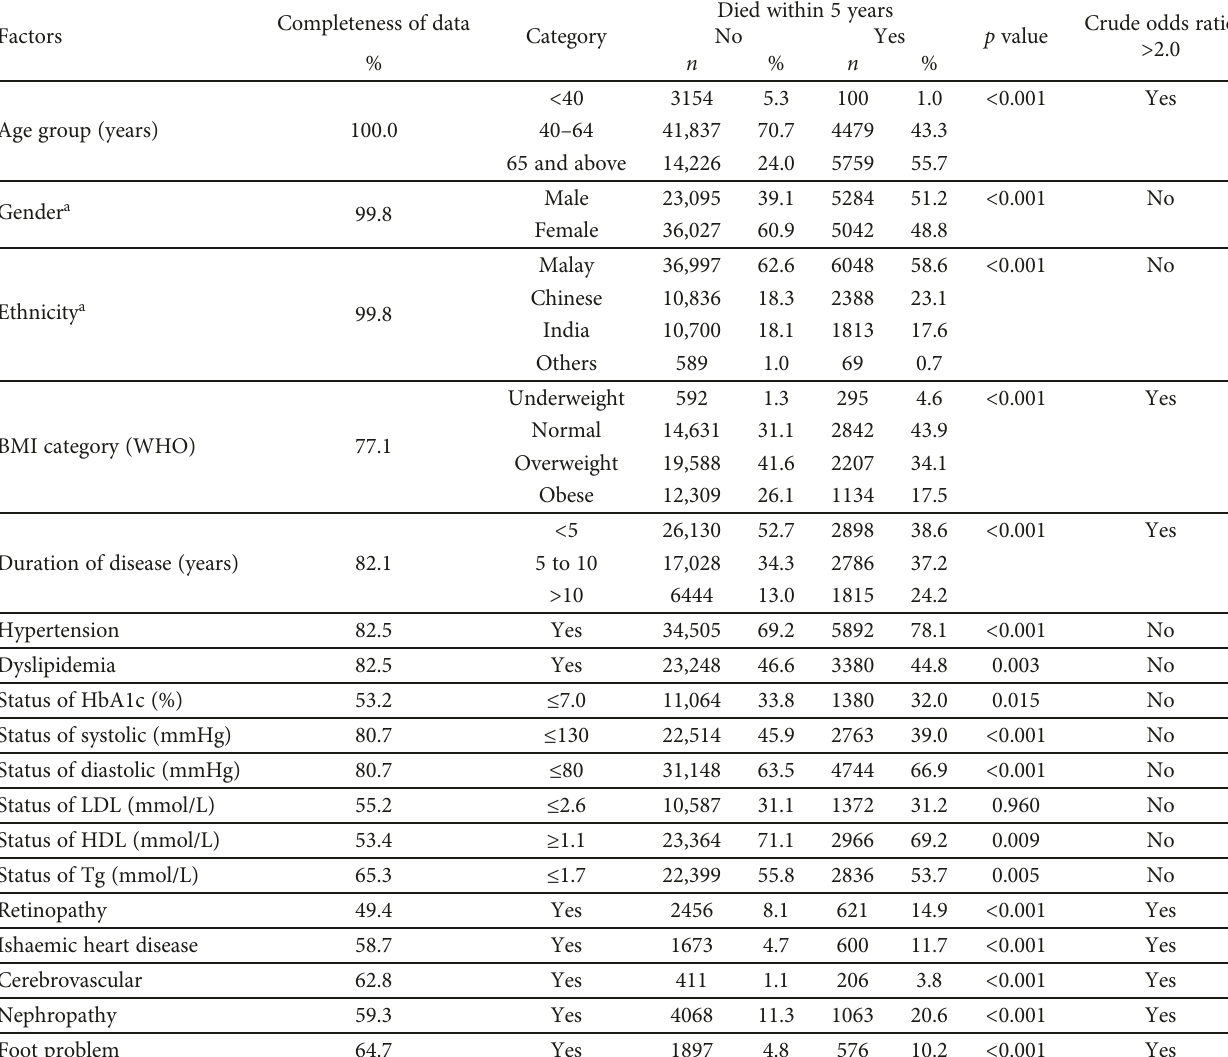
Table 2: Result of univariate association between factors and status of death within fi ve